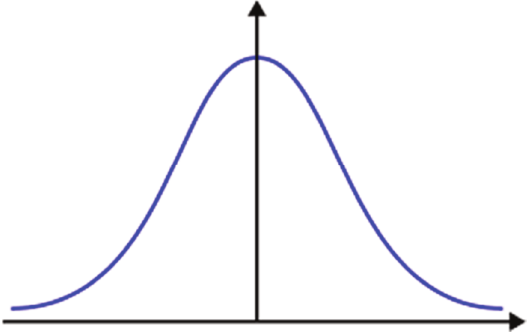
Fig. 5. Function defining the weights of the measuring points Determining the input data of the control algorithms based on the developed program consists of loading the data file from experimental tests, specifying the desired mesh values and starting the calculation process. It is also possible to choose the type of isoline smoothing, as well as the Line/Square plot type.